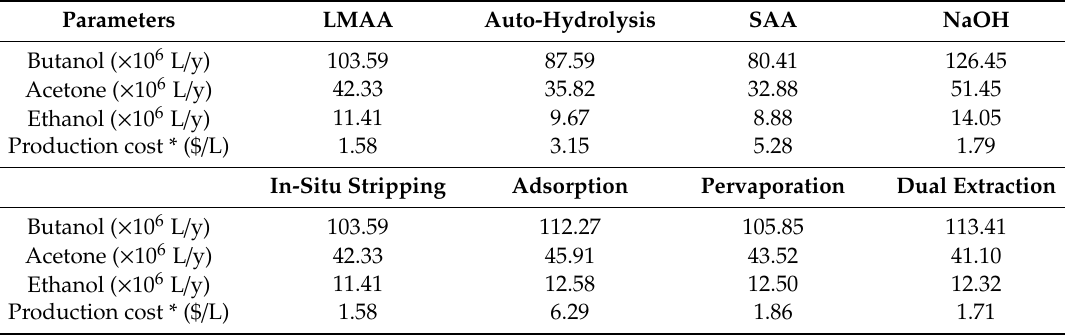
Table 3. Products yield from di ff erent simulated plant set-up.